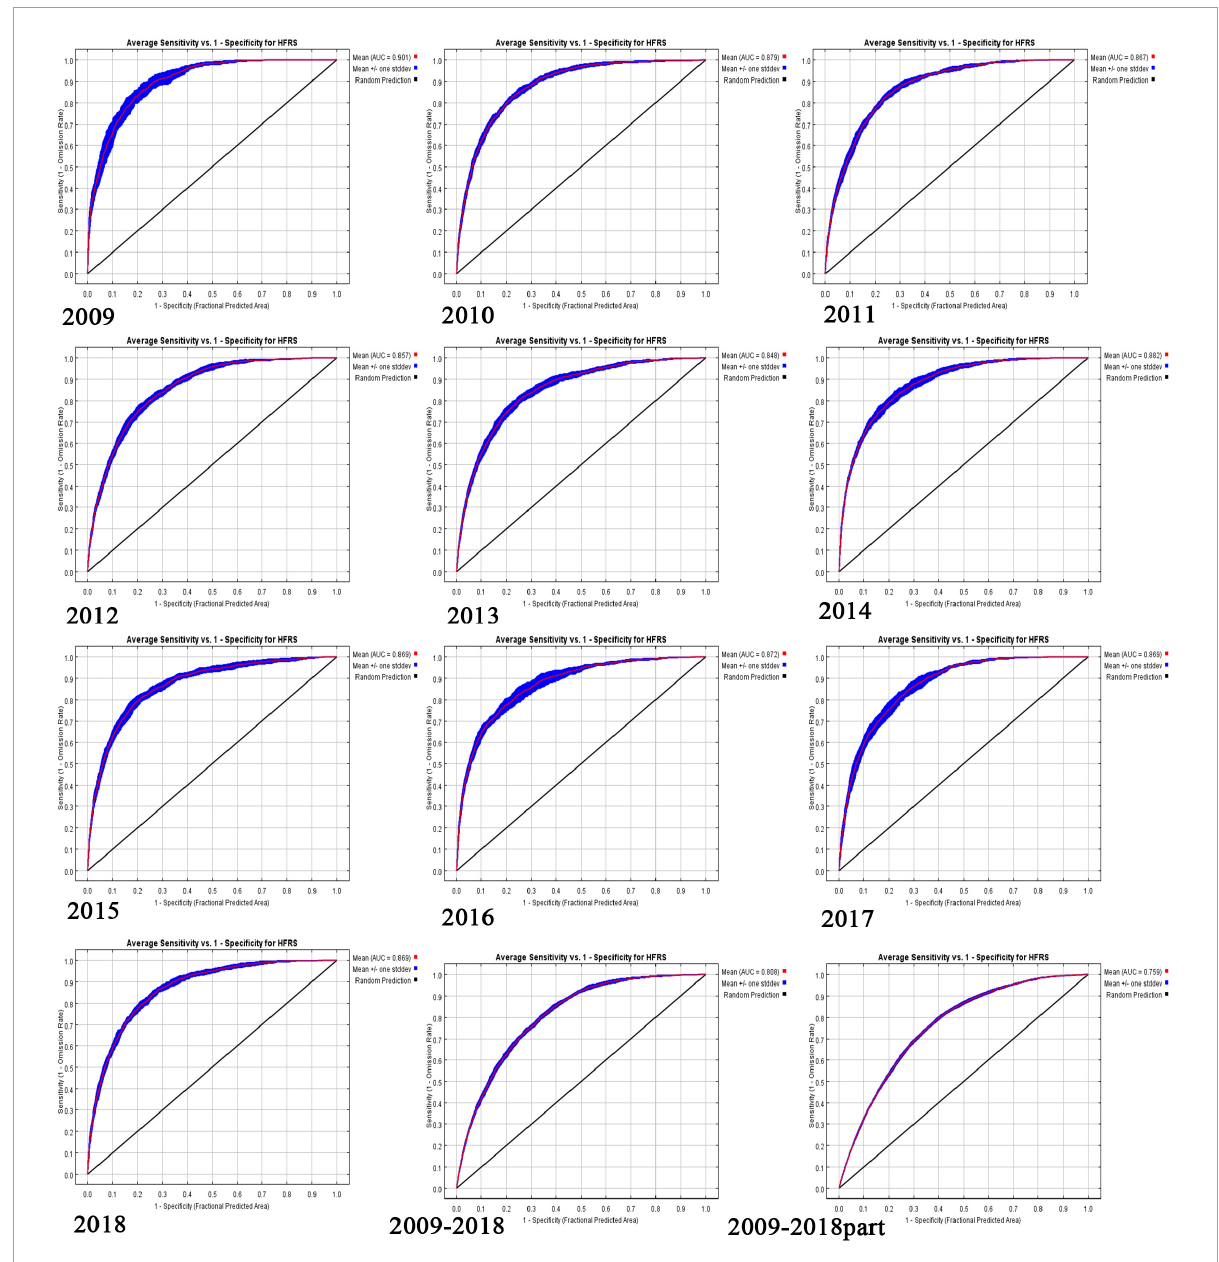
FIGURE1 The receiver operating characteristic (ROC) curve for HFRS from 2009 to 2018.